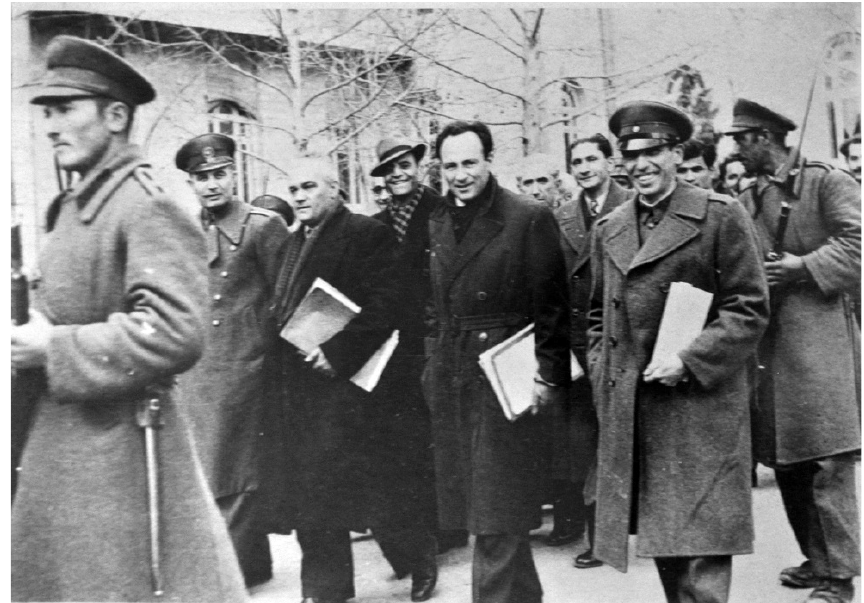
Figure 6. Noureddin Kianouri (centre) and Morteza Yazdi (left) from Tudeh Party are being taken to the court, 1949. Source: Afsaneh Gidfar family